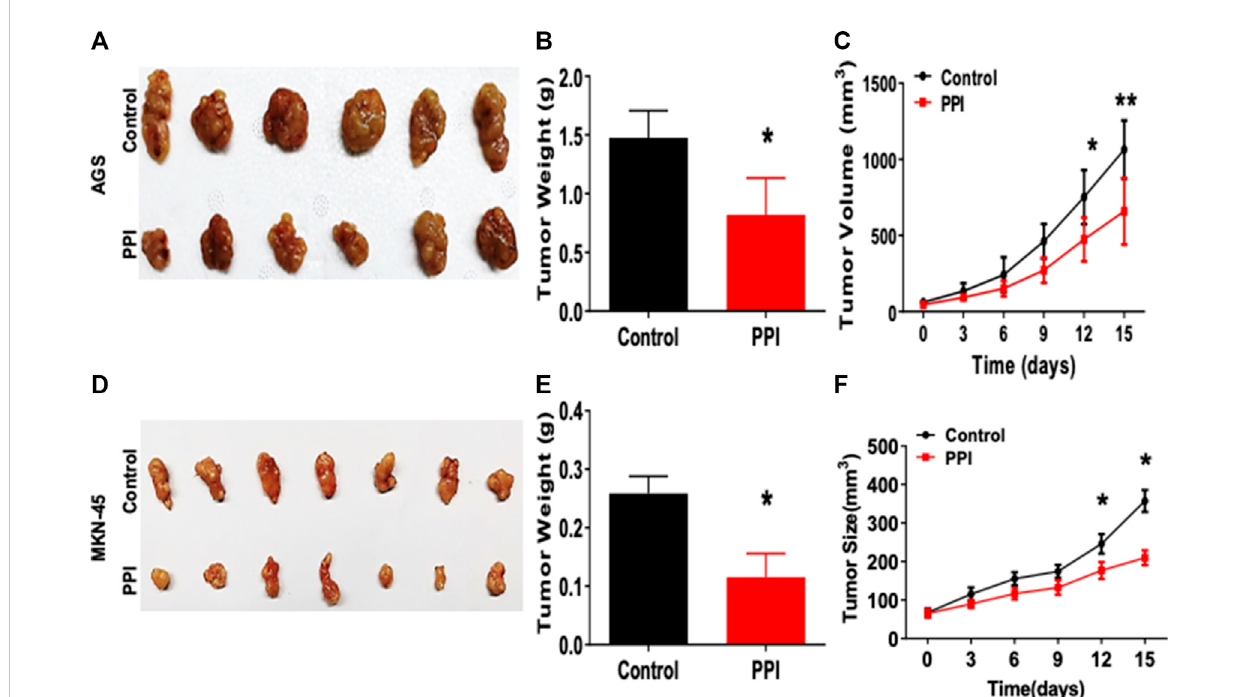
FIGURE 1 PPI inhibits the tumor growth of AGS and MKN-45 cells in BALB/c nude mice. BALB/c nude mice were injected subcutaneously with 1 × 10 6 AGS or 2 × 10 6 MKN-45 human tumor cells. One week after inoculation, mice were administrated with the solvent (Control) or PPI (3 mg/kg/day) for up to 15 days. (A) Tumor xenografts (AGS) were harvested at day 15. Shown are photos of the tumors derived from control vehicle- and PPI-treated mice. (B) Then, the tumor weights were also measured at day 15. (C) The tumor volumes were determined at various time points. (D – F) Similarly, Tumors (MKN-45) also were harvested for taking tumor photos (D) and measuring tumor weights (E) as well as tumor volumes (F) . Data are presented as mean ± SD ( n = 6 mice/group) and analyzed using the unpaired- t test (* p <